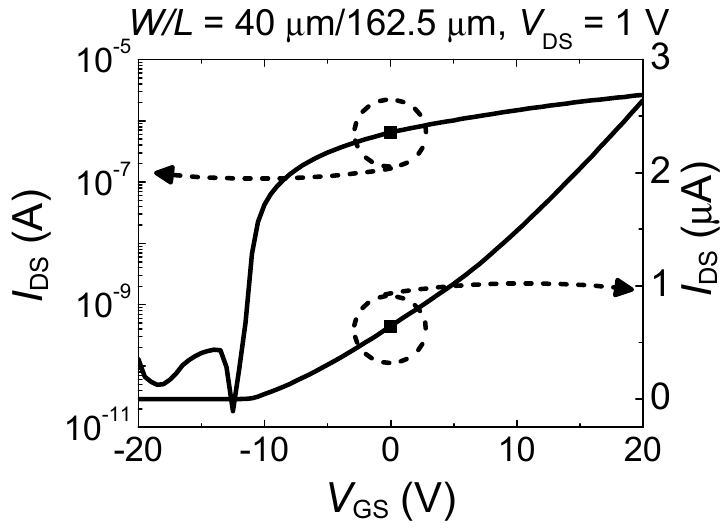
Figure 2. Transfer curve of the a-IGZO Hall bar-patterned TFT.